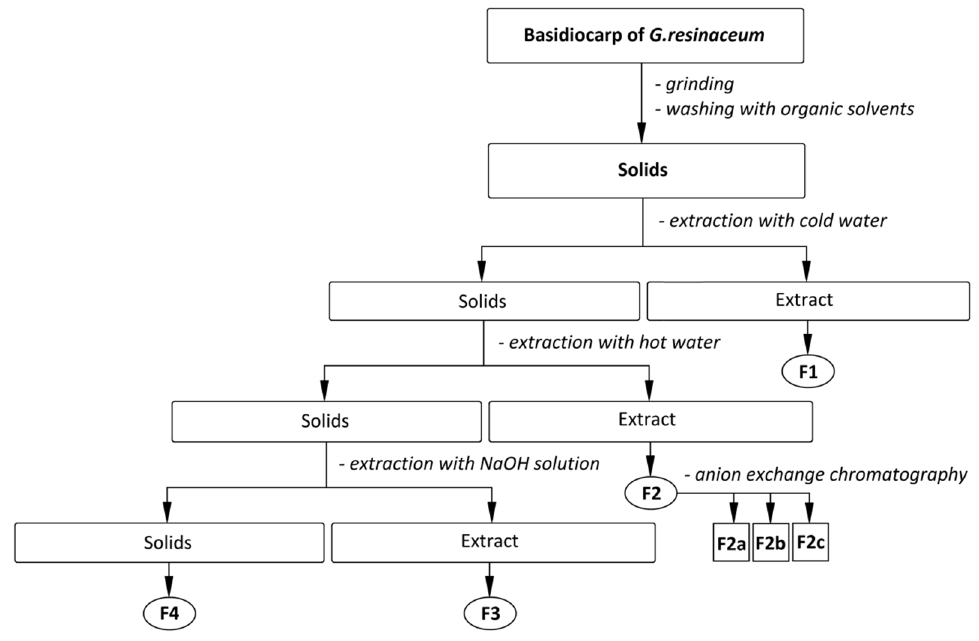
Figure 2. The scheme of isolation of the polysaccharidic fractions F1 , F2 , F3 , and F4 and sub ‐ fractions F2a–c from basidiocarps of G. resinaceum . F2a–c from basidiocarps of G. resinaceum